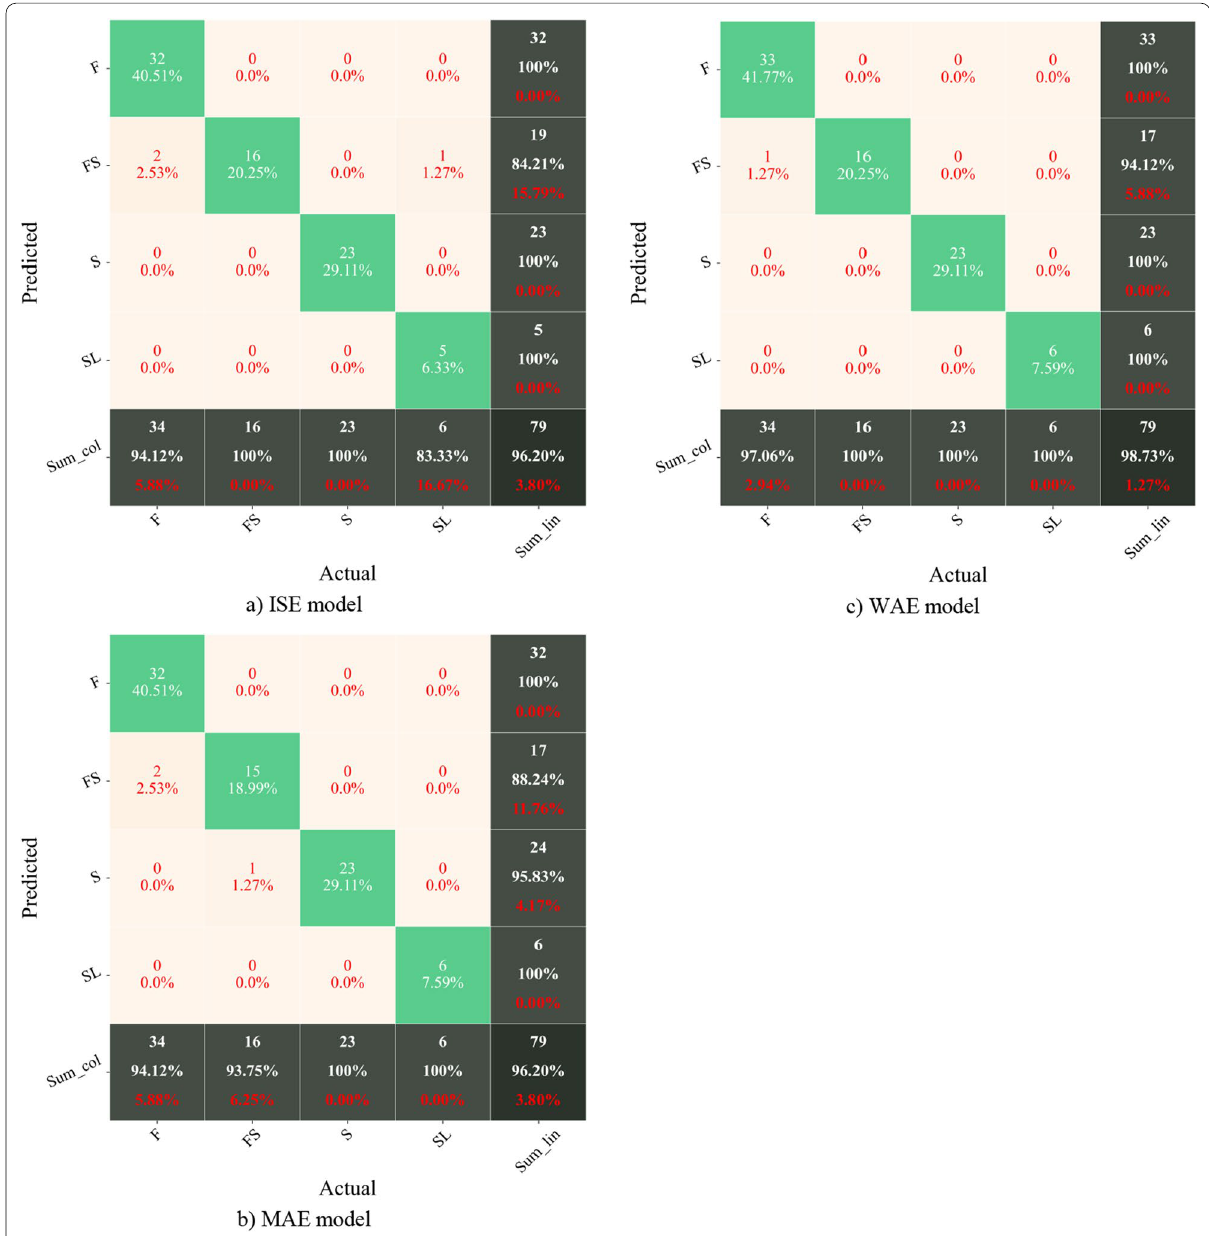
Fig. 9 Confusion matrix of various models. a ISE model. b MAE model. c WAE